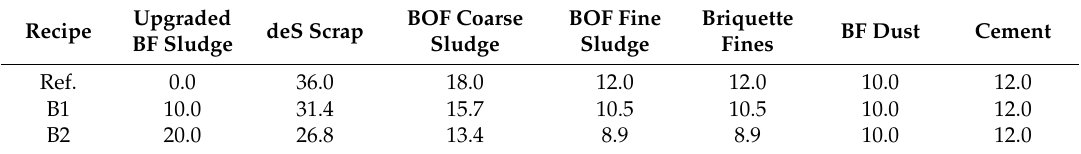
Table 2. Recipes of the briquettes used in the laboratory scale and pilot-plant scale BF experiments.